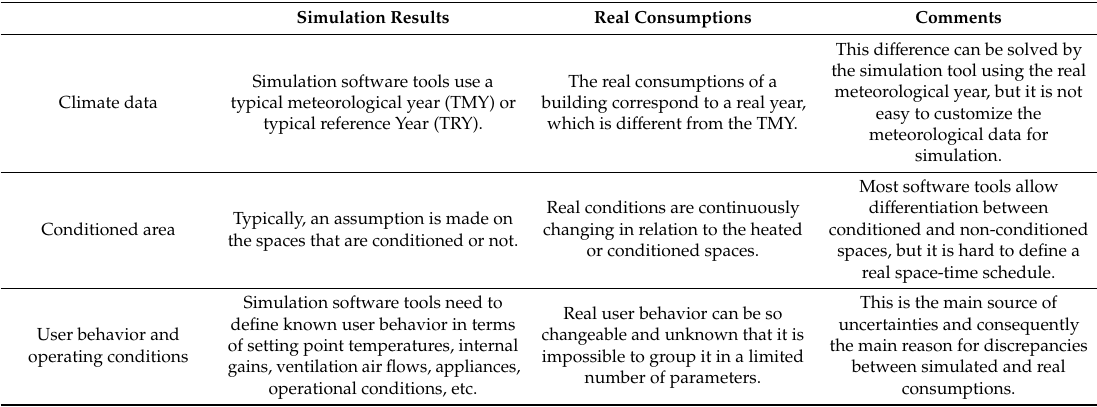
Table 1. Analysis of main di ff erences between the simulated results and the real